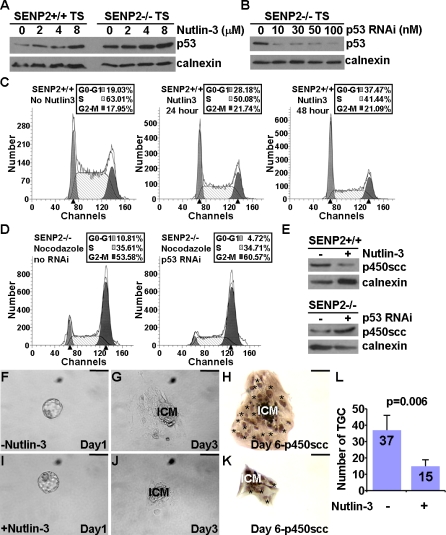
Repression of p53 Is Necessary and Sufficient to Promote Trophoblast Proliferation and Differentiation(A,B) Nutlin-3 stimulates p53 in a dosage-dependent manner (A) and accumulation of p53 in the SENP2-nulls can be knocked down by RNAi (B). Protein lysates, isolated from SENP2+/+ and SENP2–/– TS cells treated with Nutlin-3 (A) or transfected by p53 RNAi (B), were analyzed for the p53 expression by immunoblot. Calnexin was used as a loading control.(C) Activation of p53 by Nutlin-3 caused a delay in the G1–S transition. Flow cytometric analysis of PI-stained SENP2+/+ TS cells determined the cell cycle profiles without Nutlin-3 or affected by Nutlin-3 treatment for 24 or 48 h. The Nutlin-3 (8 μM) treatment induced a cell cycle arrest at G1–S.(D) The p53 RNAi treatment alleviates the cell cycle defects caused by the SENP2 deletion. The SENP2–/– TS cells with or without p53 RNAi (100 nM) were treated with nocodazole for 30 h. Flow cytometric analyses revealed that the cell population arrested in G0–G1 of SENP2–/– TS cells was reduced by the p53 knockdown. (C,D) are representatives of two independent experiments.(E) Stimulation of p53 is necessary and sufficient to inhibit trophoblast maturation. Protein lysates, isolated from SENP2+/+ and SENP2–/– cells with or without the Nutlin-3 (8 μM) treatment and the transfection of p53 RNAi, were analyzed by immunoblot analysis for the expression of a TGC marker p450scc. Calnexin was used as a loading control.(F–K) Nutlin-3 inhibits differentiation of blastocysts into TGCs. Isolated blastocysts were cultured for trophoblast differentiation in the absence (F–H) and presence (I–K) of Nutlin-3 (8 μM) in vitro. Images were taken at culturing day 1 (F,I), day 3 (G,J) and day 6 (H,K). The cultures were then analyzed by immunostaining of a TGC-specific marker p450scc (brown) and counterstaining by hematoxylin (blue) on day 6 (H,K). Asterisks indicate TGCs.(L) The graph shows the average number of TGC present in the cultures (p = 0.006, n = 4).Scale bars, 100 μm (F–K).